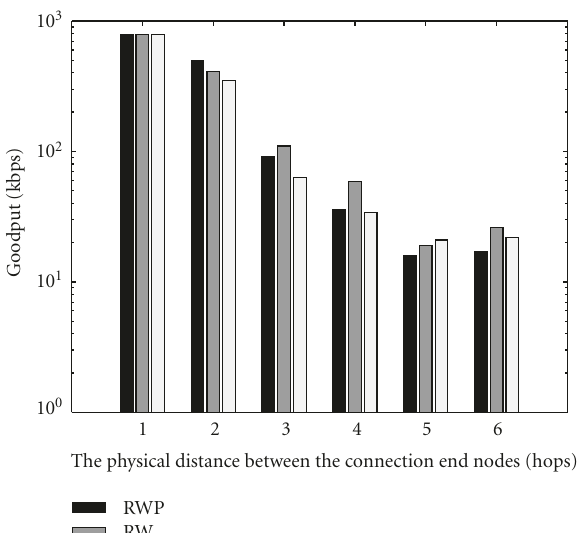
Figure 8: TCP goodput for Bypass-AODV routing protocol.